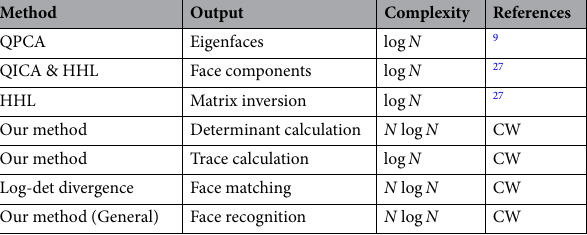
Table 2. Summary of estimated complexities in quantum face recognition